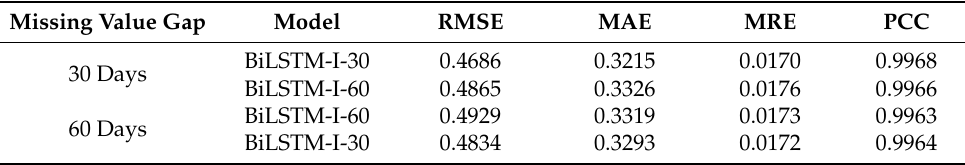
Table 4. Statistics for the imputation accuracy of the BiLSTM-I model applied to missing values over 30- and 60-day